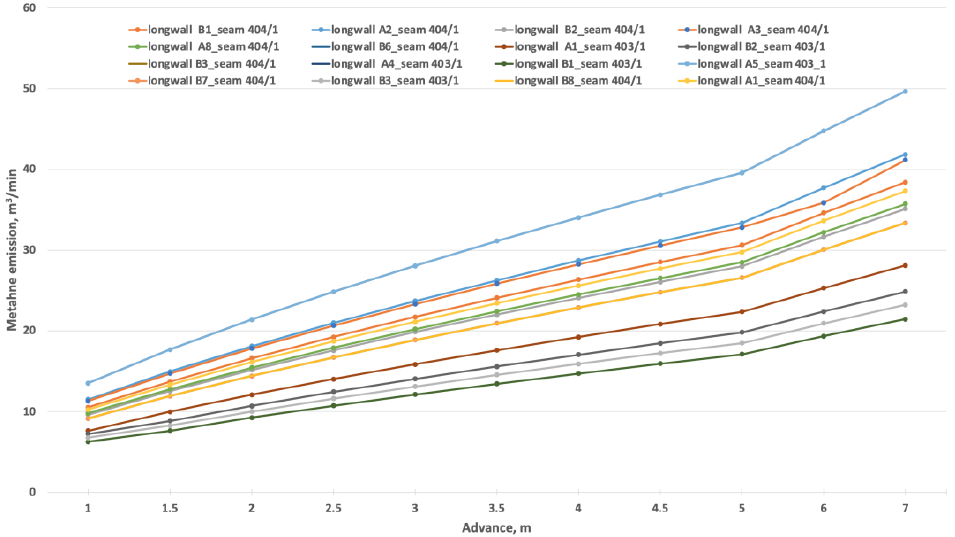
Figure 7. Relationship between methane emission and advance of the longwall panels in the 403/1 and 404/1 coal